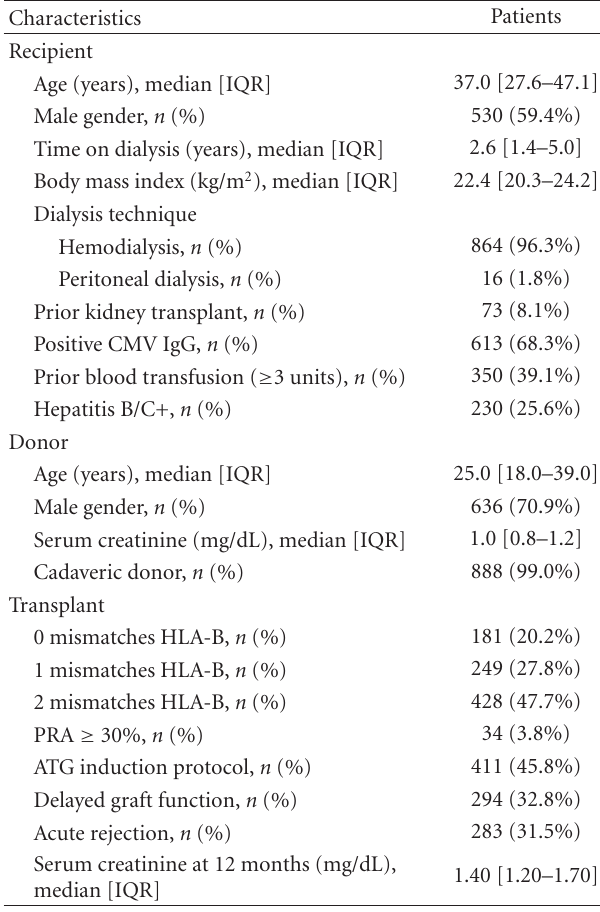
Table 1: Recipient, donor, and kidney transplant characteristics of the enrolled population ( n =